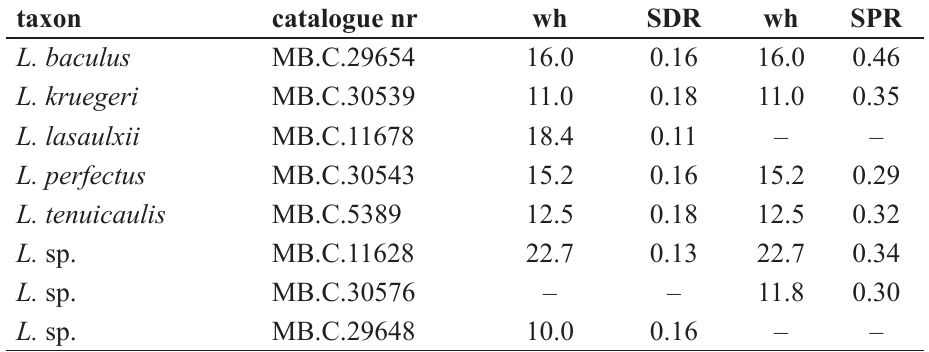
Table 11. Siphuncular diameter ratio (SDR) and siphuncular distance ratio (SPR) at their corresponding whorl height in specimens of Lituites Bertrand, 1763.